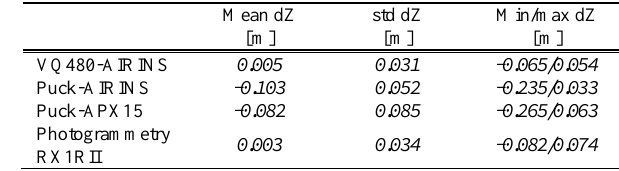
Table 4: Altimetric statistics for DTM error related to GCP’s (40)